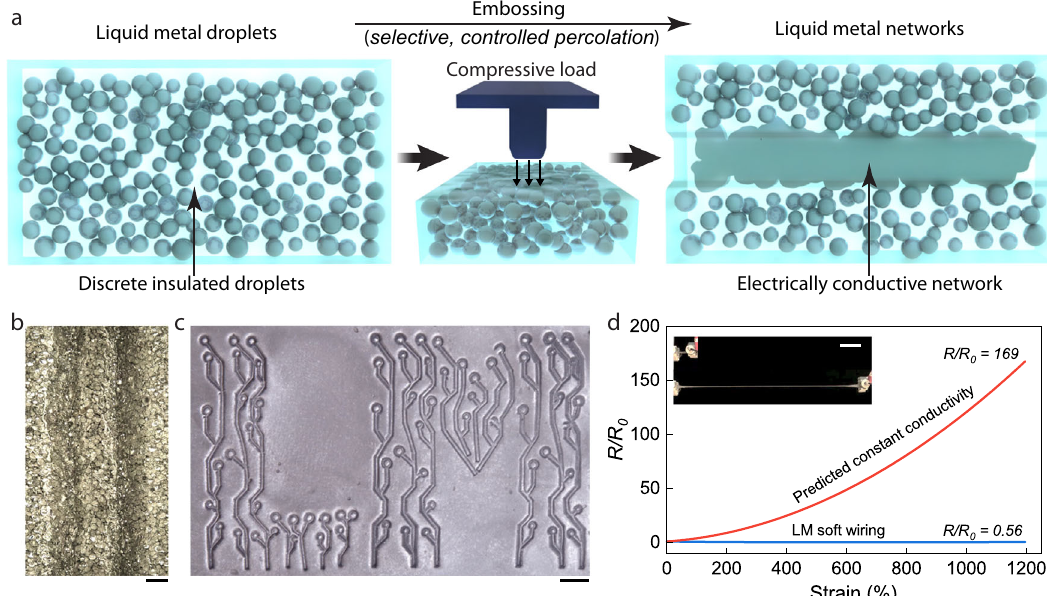
Fig. 2 Creating robust conductive traces. a Schematics to illustrate the process of embossing, where discrete insulating droplets of liquid metal are selectively embossed to form a connected conductive network. b Optical micrograph of an embossed region shows the distressed composite, which is electrically conductive, scale bar — 250 μ m. c Embossed pattern in the form of letters L and M with intricate lines and connections (scale bar — 10 mm). d A plot of R / R 0 vs. applied strain on a conductive trace ( ϕ = 60%, δ = 10%). The red curve shows the predicted R / R 0 increase with applied strain for a metallic conductor, while the embossed liquid metal conductive trace (blue curve) shows constant or a reduction of R / R 0 (0.56 at 1200% strain compared to 169 for the prediction). The inset shows images of an unstrained sample and a sample at 1200% strain (scale bar — 50 stretchability of the embossed traces. The initial electrical con- are exceptional compared to a wide range of previous stretchable ductivity can be calculated from the trace dimensions as 150 S cm − 1 , conductors 18,22,35 – 47 , highlighting the electrical performance and which reaches as high as 45 400 S cm − 1 at 1200% strain. These extreme compliance of our resilient liquid metal composite con- ductors (Supplementary Fig. 3a, b). values of conductivity and normalized resistance at maximum strain